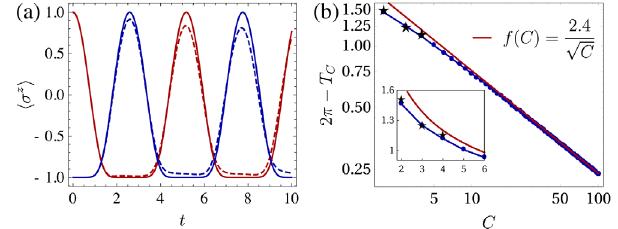
FIG. 4. (a) TDVP dynamics on a tree (solid lines) compares favorably with exact dynamics on a 4 × 4 lattice (dashed lines). Different colors denote different sites in the unit cell. (b) Scaling of the period of the isolated periodic orbit as a function of the connectivity of the TTS. Stars indicate exact results for chain, honeycomb, and square